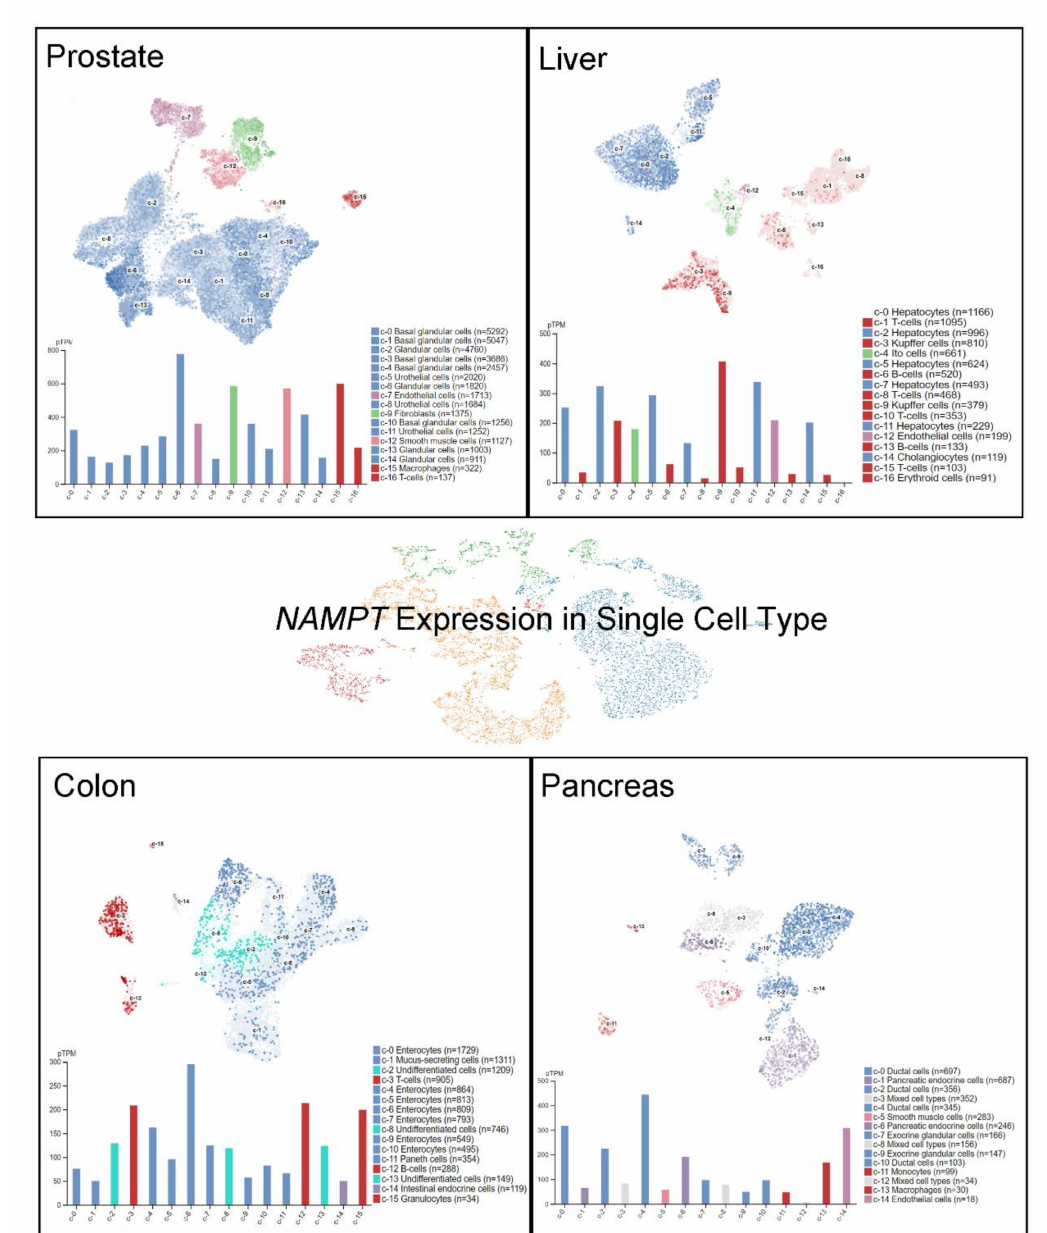
Figure 3. Human NAMPT expression in single cells of different cell types. The NAMPT level was detected by scRNA-seq in various tissues. The RNA expression levels in the cell type clusters were identified in each tissue and visualized by using the UMAP plot of single